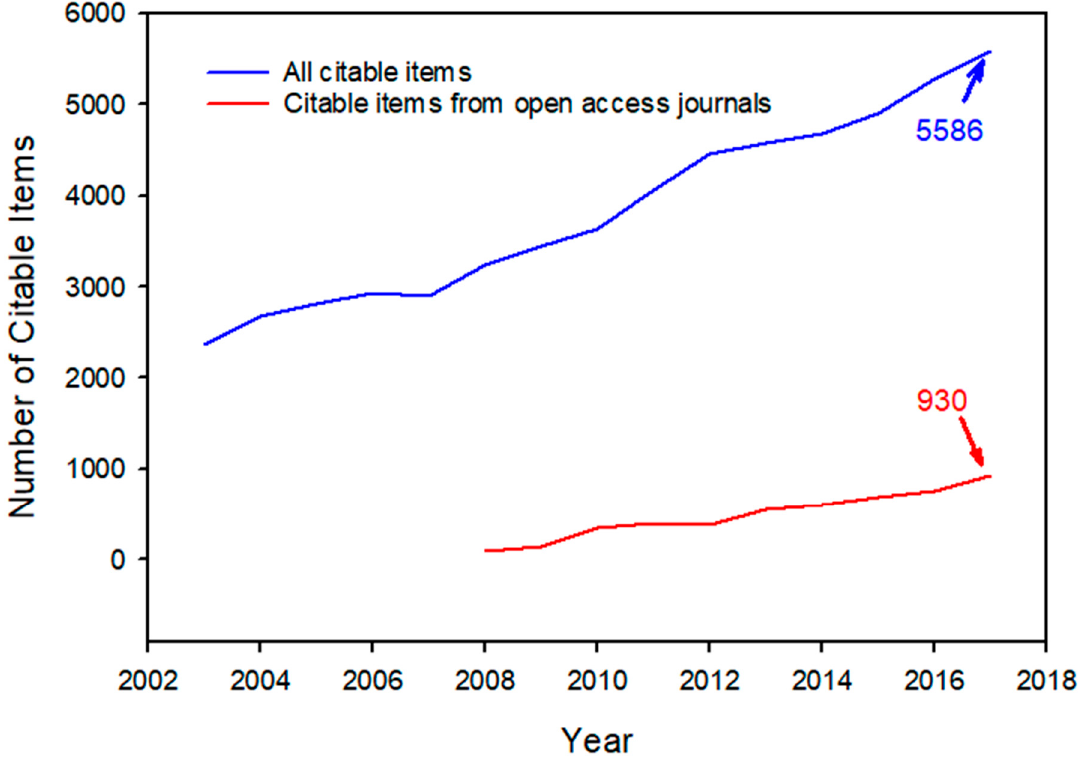
Figure 1. Cumulative total number of citable items (blue) and number of citable items from open access journals in the Clarivate Analytics data for “forestry”. Numbers show values in 2017. Open access citable items represent an increasing percent of total citable items in the forest